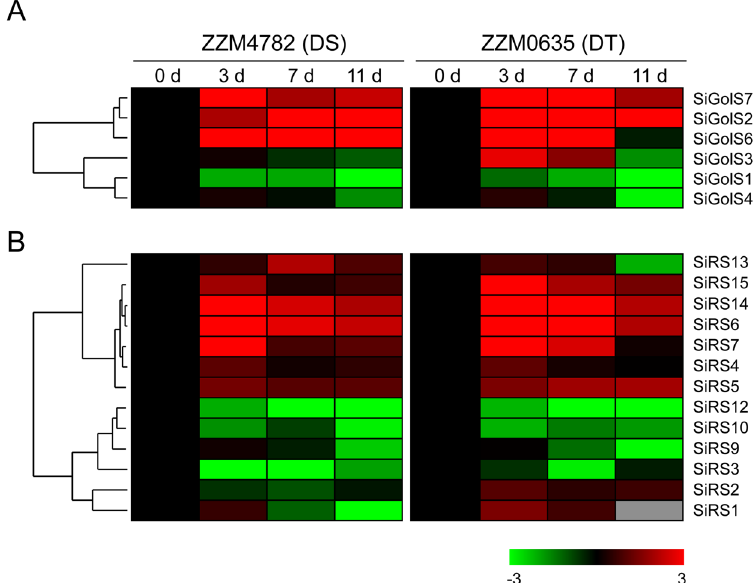
Figure 4. Expression profiles of SiGolS and SiRS genes under drought stress. The log 2 -transformed values (mean of three replicates) of the relative expression levels of the SiGolS ( A ) and SiRS ( B ) genes under drought stress in ZZM4782 (drought-sensitive, DS) and ZZM0635 (drought-tolerant, DT) varieties were used for creating the heatmap using Cluster 3.0. Gray box indicated the gene-expression change is not available at this time point. Changes in gene expression are shown in color as the scale.